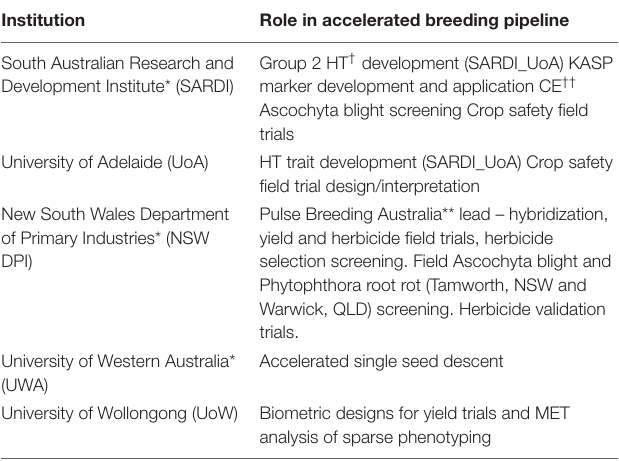
TABLE 1 | Collaborating institutions, locations, and roles. Institution Role in accelerated breeding pipeline